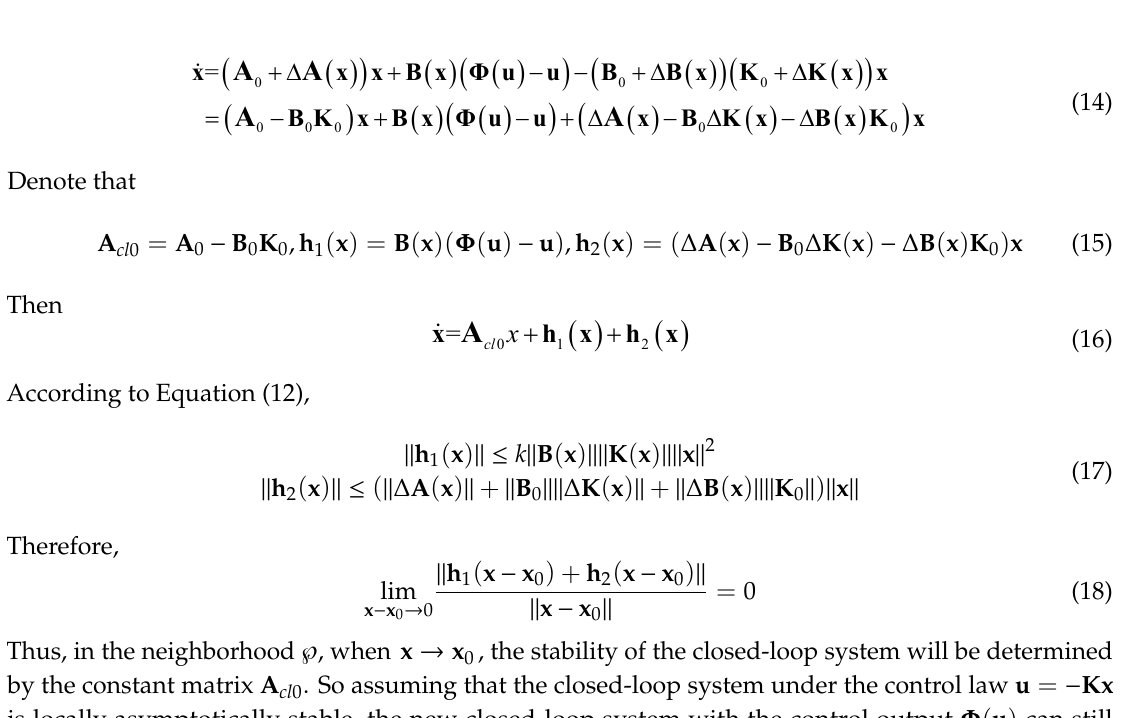
Figure 5. The flight velocities of the RLV.